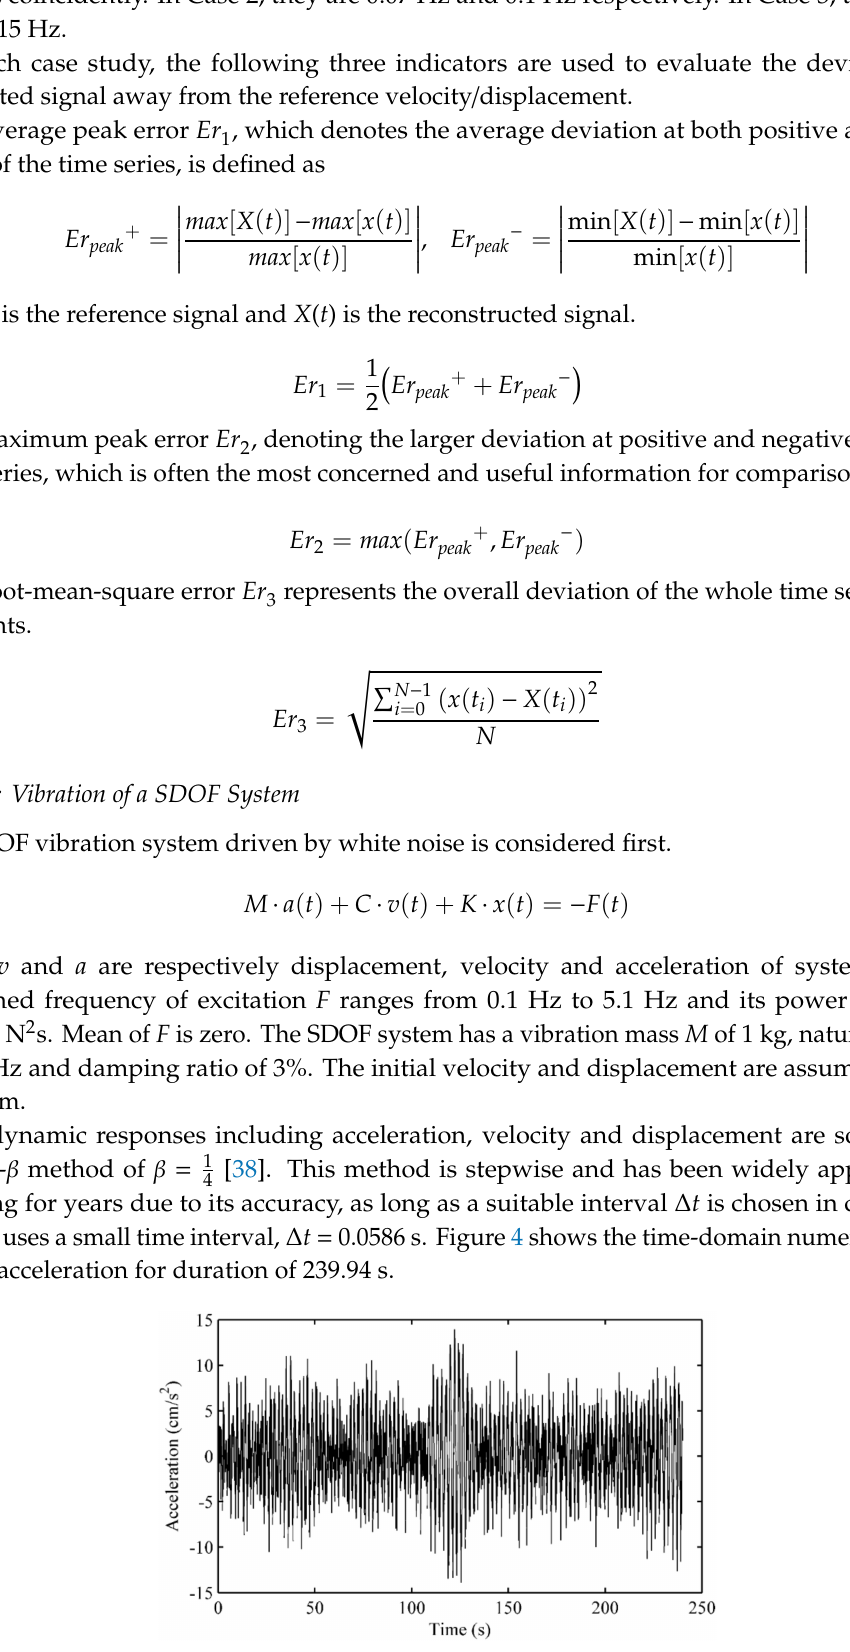
Figure 4. Simulated acceleration time history of single-degree-of-freedom (SDOF)